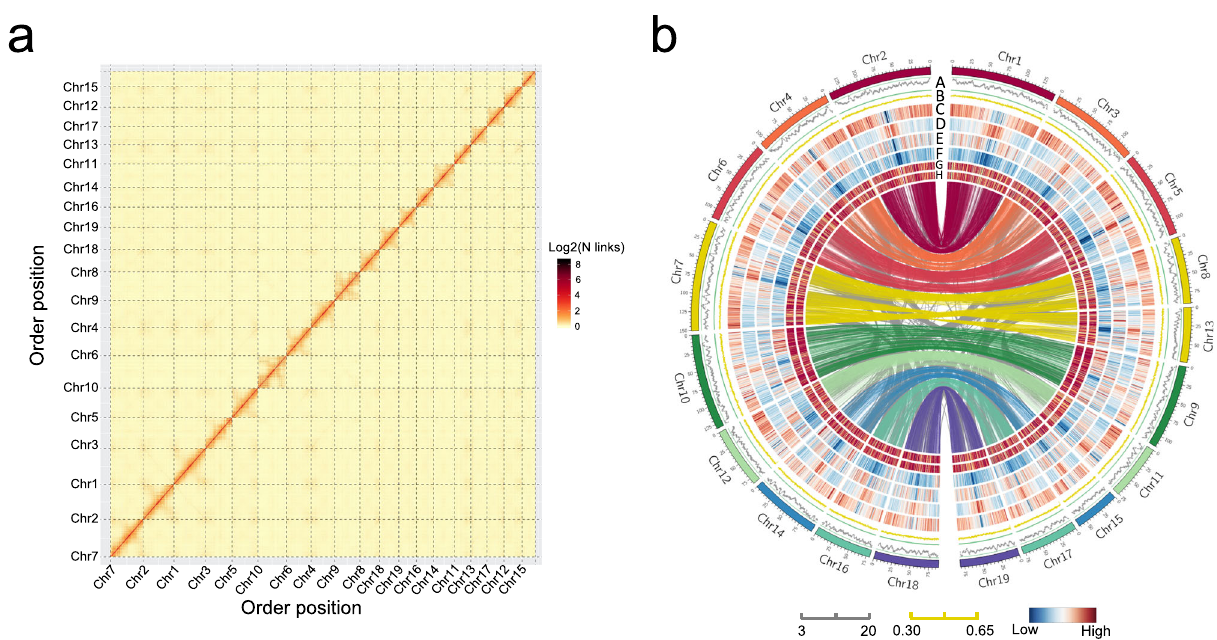
Fig. 1 Overview of the M. lutarioriparius genome assembly. a Genome-wide Hi-C map of M. lutarioriparius . Post-clustering heatmap shows density of Hi-C interactions between contigs from LACHESIS pipeline. b Circos plot of M. lutarioriparius genome assembly. The outermost layer of colored blocks is a circular representation of the 19 pseudochromosomes, with scale mark labeling each 5 Mb. The LTR Assembly Index (LAI) score is shown in track (A). The density of GC content (B), gene (C), Gypsy (D), Copia (E), DNA TE (F), transcriptome expression level of rhizome (G), and lateral bud (H) were calculated using 100 kb non-overlap window. The innermost layer shows inter-chromosomal synteny, with colored upper-layer links representing syntenic blocks generated from the recent M. lutarioriparius WGD, and the gray low-layer links representing homologs generated from older